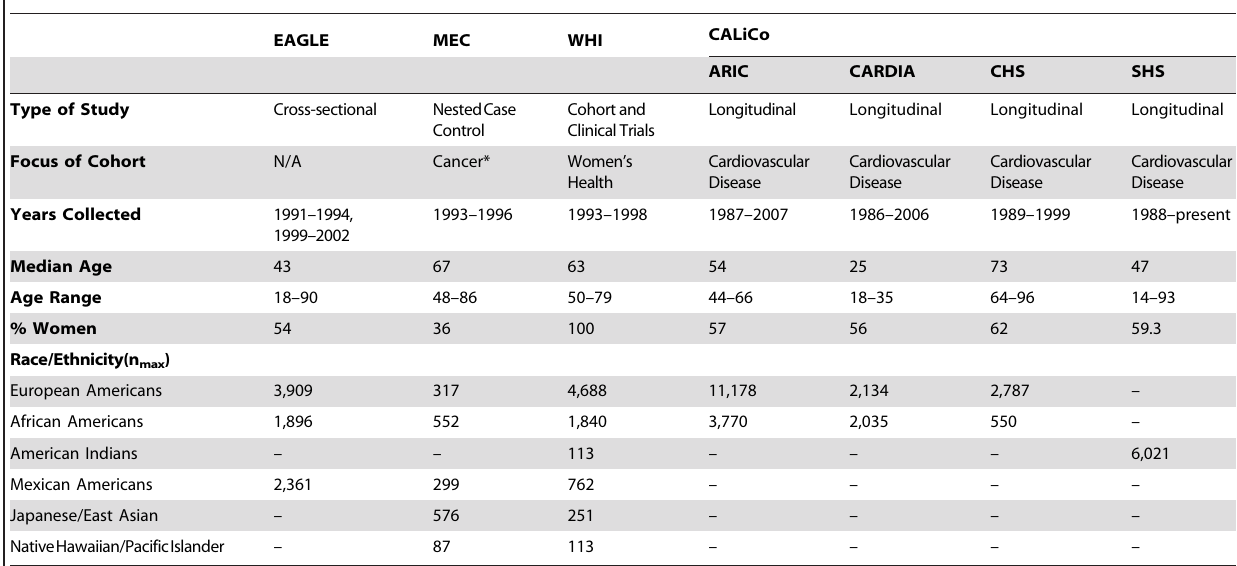
Table 4 and in Figure S1, by population. We calculated the Pearson correlation coefficient (r) and F ST between European American coded allele frequencies and all other groups. The highest correlation was observed in the comparison with Mexican Americans/Hispanics (0.97) followed by American Indians (0.92), Native Hawaiians/Pacific Islanders (0.90), Japanese/East Asians (0.87), and African Americans (0.84). Compared with European Table 1. Characteristics of PAGE study